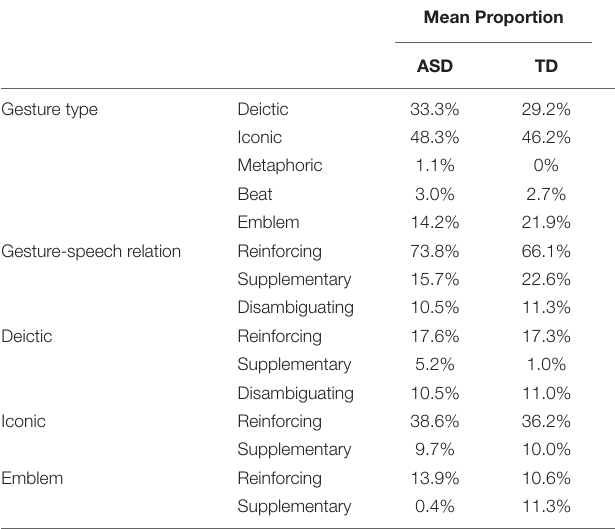
TABLE 2 | Constitution of gestures produced by the ASD and TD group.